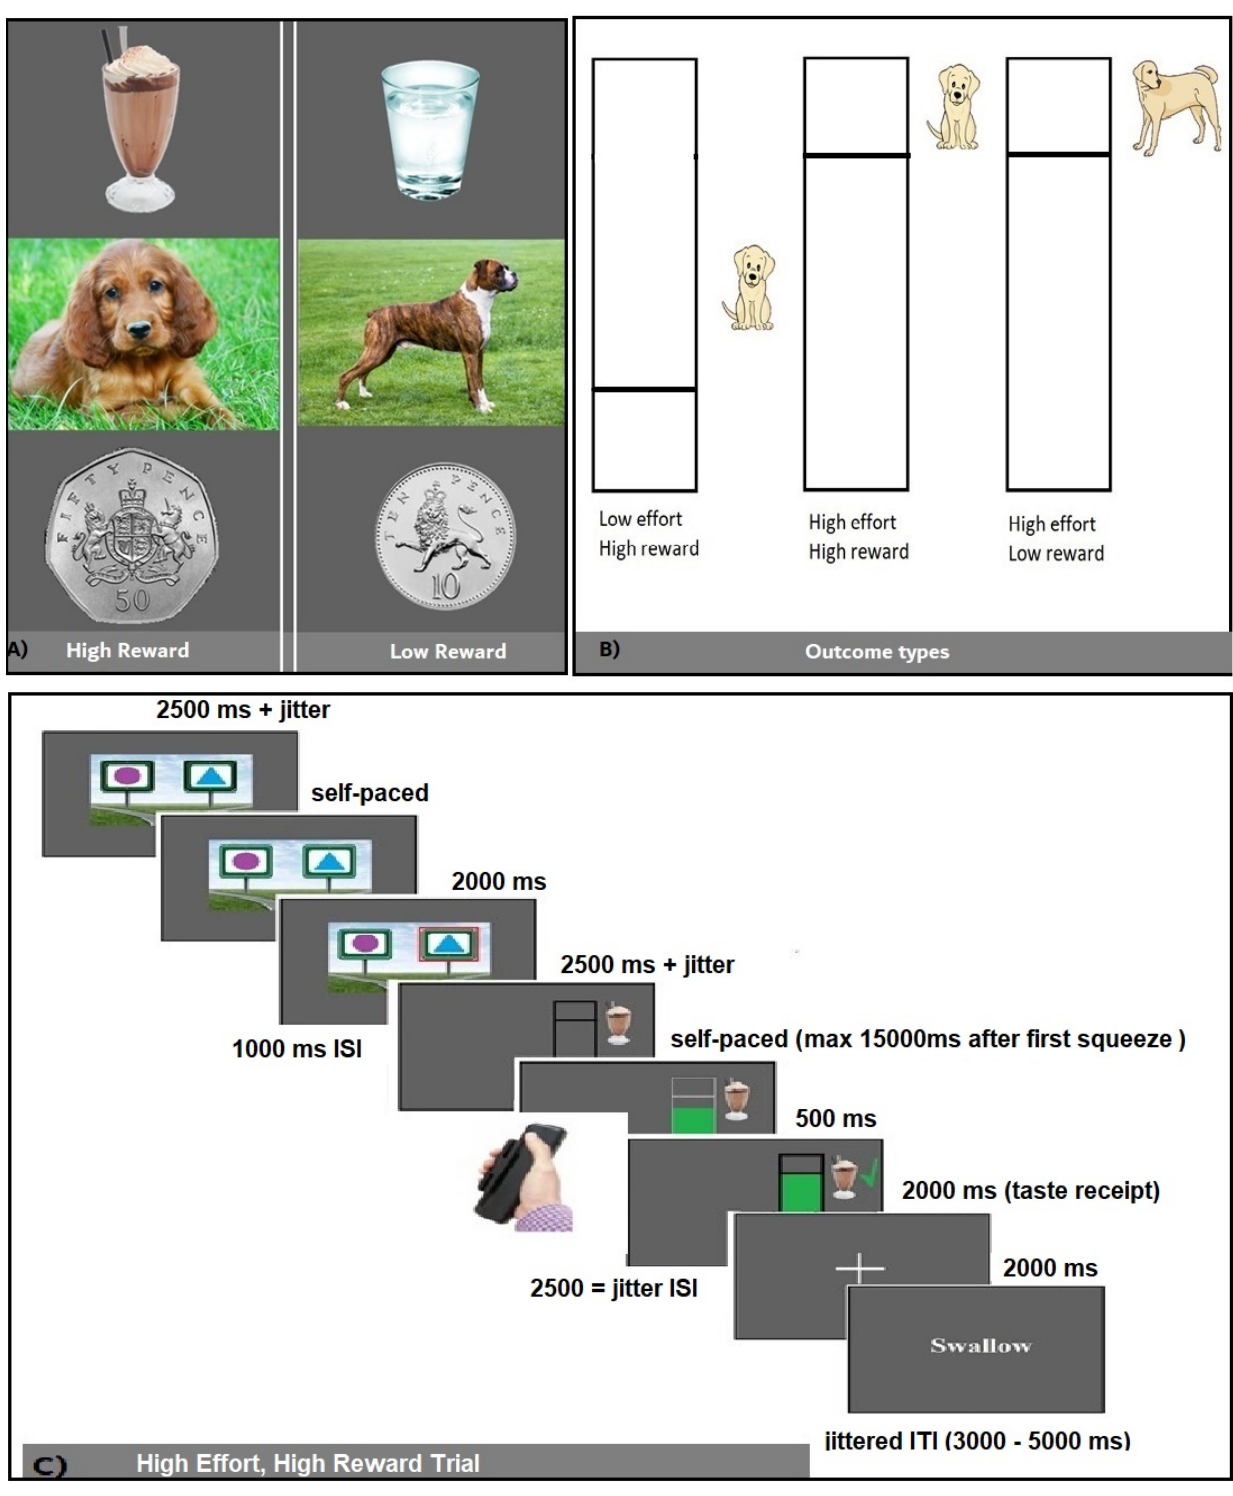
Figure 1. High Reward = Chocolate, Low Reward = Figure 1. ( A ) Reward conditions: High Reward = Chocolate, Low Reward = Water; High Reward = Puppies, Low Reward = dogs; High Reward = 50 p, Low Reward = 10 p. ( B ) Outcome types: Low Effort for High Reward; High Effort for High Reward; High Effort for Low Reward. ( C ) Example High Reward (chocolate) for High Effort trial During the tasks, every trial started with the option to choose between two shapes, shown on the left and right sides of the screen (see Figure 1C). Choices were made by pressing a key on the keyboard (z for the left option and m for the right option). Each option was associated with both a reward and a physical effort, but the left and right op- tions differed in the level of the associated reward or effort. Effort and reward learning trials were interleaved, and each trial type was associated with one shape pair (i.e., the task included a total of two shape pairs/four shapes). On effort learning trials (shape pair 1), the effort level was probabilistic (80% vs. 20% high effort for the left vs. right option, sides counterbalanced), while the reward level was high for both options. On the reward learning trial (shape pair 2), the reward level was probabilistic (80% vs. 20% high reward for the left vs. right option, sides counterbalanced), while the effort level was high for both options. Participants were instructed to choose those options that resulted in receiving high rewards and/or avoiding high effort levels. The high effort level was set to 80% of fmax and the low effort level to 20% of fmax. Depending on the reward condition, high rewards were either a taste of chocolate, a picture of a puppy, or 50 p and low rewards were either a taste of water, a picture of a dog, or 10 p. The tastes were delivered in 0.5 mL aliquots via long tubes to the participant, who held the tubes in their mouth. This amount is perceived as rewarding and prevents habit- uation, similar to our previous studies [32]. Once a choice was made, patients were informed about the outcome, i.e. the reward and effort levels were shown on the screen (reward: chocolate image, puppy line drawing, or money coin; effort: a visual target to reach within a black rectangle outline; see Figure 1). Next, the rectangle outline turned white, signaling to participants to start exerting ef- fort. Participants were required to squeeze the handgrip until the green bar reached the target (horizontal line) and to hold the target force for 1 s. Any force participants exerted beyond the target was not shown on the screen but was recorded to determine the